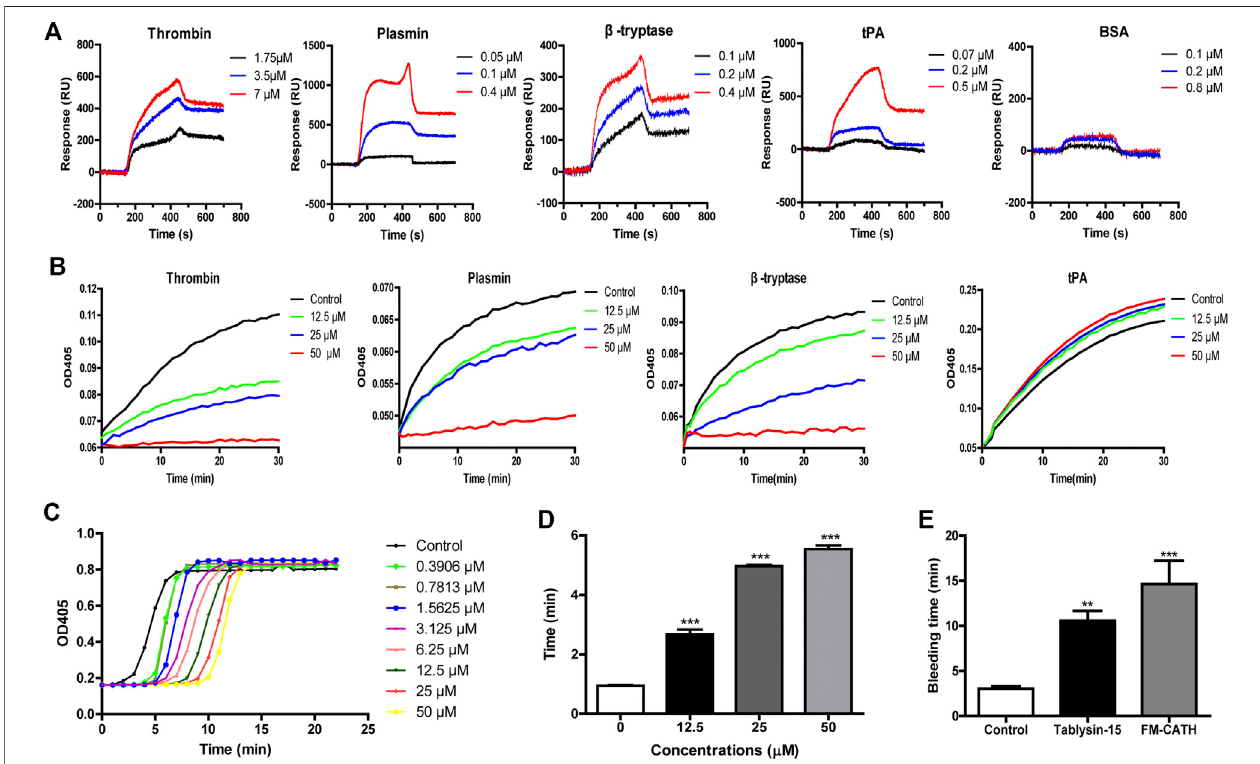
FIGURE 6 | The effects of FM-CATH on coagulation (A) SPRi analysis of thrombin, plasmin, β -tryptase, tPA, and BSA binding to FM-CATH immobilized on a gold chip. (B) Effects of FM-CATH on chromogenic substrate hydrolysis by serine proteases. The anticoagulation effect of FM-CATH measured by PRT (C) and APTT (D) assays. (E) Effect of FM-CATH on mice tail bleeding time. Data are reported as mean ± SEM (n (cid:1) 6). ** p < 0.01 and *** p < 0.001 was considered statistically signi fi cant compared with the control group.